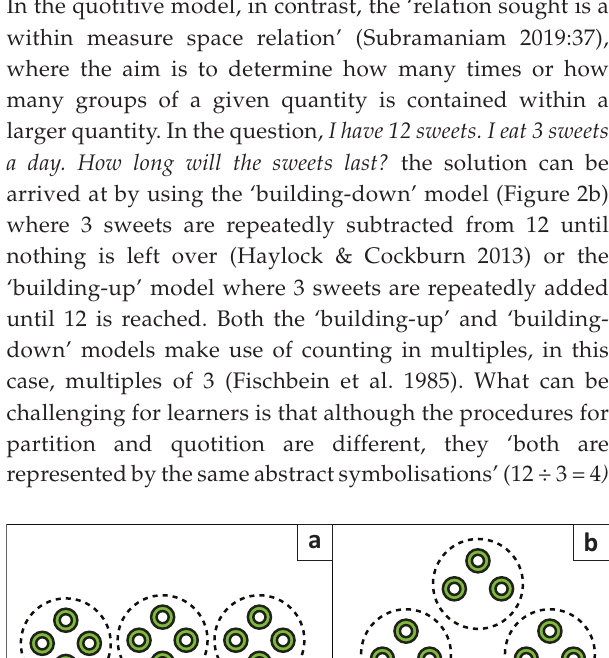
12 shared between 3 gives 4 each. 12 ÷ 3 = 4